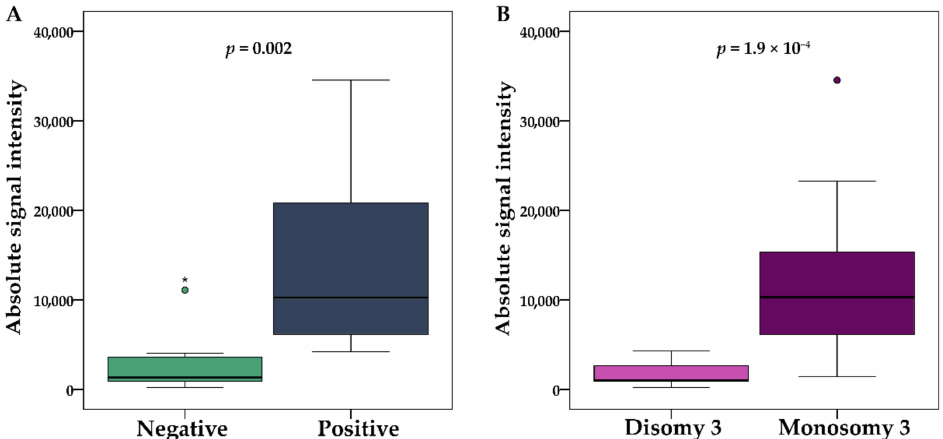
Figure 5. Differences in KIT mRNA absolute signal intensity between UM tumors with negative and positive protein expression ( A ) and D3 and M3 tumors ( B ). A horizontal line depicts the median. The boxes represent the interquartile range (IQR—values between the 75th and 25th percentiles). Values more than three IQRs are labeled as extremes (*), those between 1.5 IQRs and 3 IQRs as outliers (O). The Infinium MethylationEPIC BeadChip array containing 20 probes for the KIT gene was used to analyze DNA methylation across different regions of the KIT gene. Probes were localized in N shore ( n = 2), CpG island ( n = 8), S shore ( n = 1), S shelf ( n = 2) and inside the gene ( n = 7) (Figure 6). Individual methylation values ( β value) were evaluated for each CpG site, ranging from 0 for unmethylated to 1 for fully